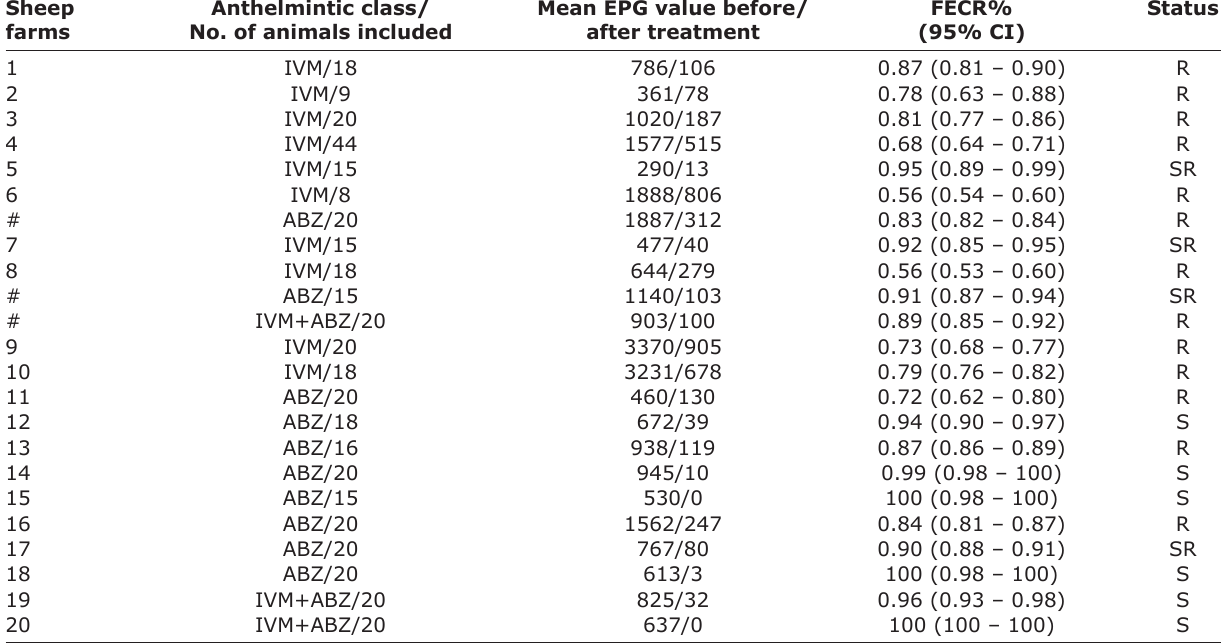
Table-2: Anthelmintic efficacy of sheep farms. Sheep Anthelmintic class/ farms No. of animals included